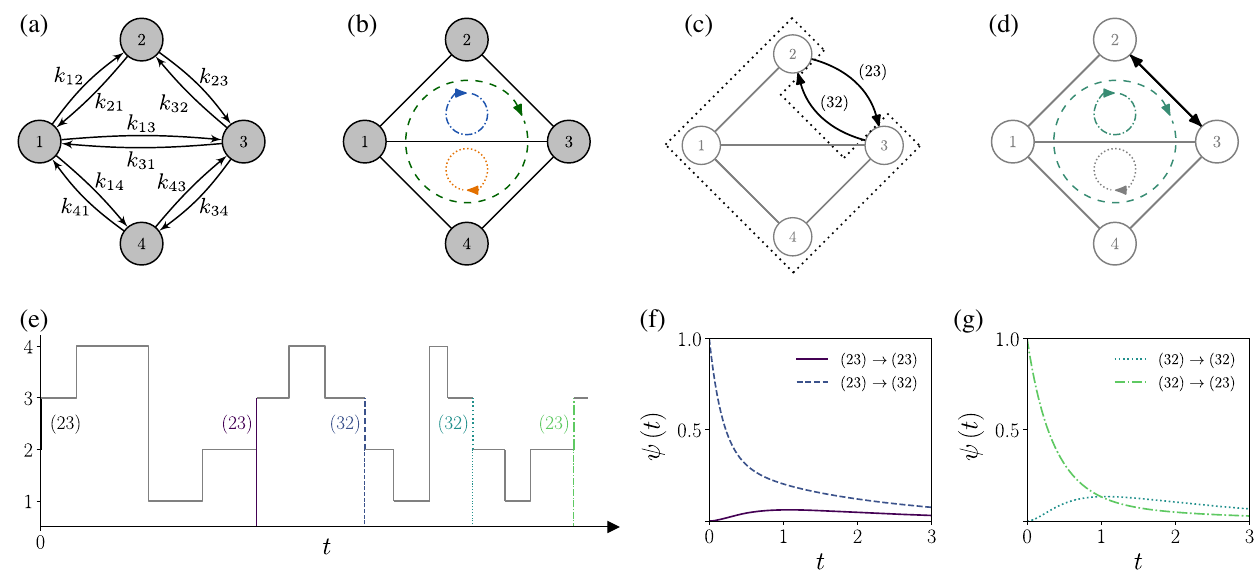
FIG. 1. Key concepts of the effective description for an exemplary Markov network. (a) Markov network including four different states. Every link between state i and state j allows for transitions in both directions with respective transition rates k ij and k ji . (b) Different cycles within the network. The three different cycles in the network are numbered incrementally starting with cycle C 12341 Þ , drawn as a green dashed curve, cycle C 1231 Þ , drawn as a blue dash-dotted curve, and cycle C 1341 Þ , drawn as 0 ¼ ð 1 ¼ ð 2 ¼ ð and A C are an orange dotted curve. By definition in Eq. (1), the affinity of C 0 is given by A C ¼ ln ð k 12 k 23 k 34 k 41 =k 21 k 32 k 43 k 14 Þ ; A C 0 1 2 defined analogously. Furthermore, these affinities coincide with A C ¼ ln P ð ↺ Þ = P ð ↻ Þ , the quotient of probabilities to observe a completed cycle in the forward and backward direction, respectively [cf. Eq. (7)]. (c) Effective description of the network if only the link between 2 and 3 is observable. Observing this link gives information about transitions between 2 and 3, i.e., (23) and its reverse (32), and intermediate waiting times. (d) Observable cycles in the effective description. Two successive transitions along the observable link indicate the completion of a cycle. As indicated with gray color, only completions of C 0 or C 1 can be registered, since C 2 does not include the observed link. Additionally, C 0 and C 1 are drawn as curves with the same color, because, by counting transitions without temporal resolution, we cannot distinguish between both cycles. (e) A trajectory and its effective description. The observable parts of a trajectory of the underlying network are transitions (23) and (32) at corresponding transition times. By conditioning the observed transitions on the previous ones, four different waiting time distributions for the different combinations of subsequent transitions can be defined. (f),(g) Waiting time distributions for the observable link for fixed transition rates. The four different waiting time distributions of the observed link are illustrated; they are calculated with the method introduced in Appendix A 3. The particular choice of transition rates is given in Appendix